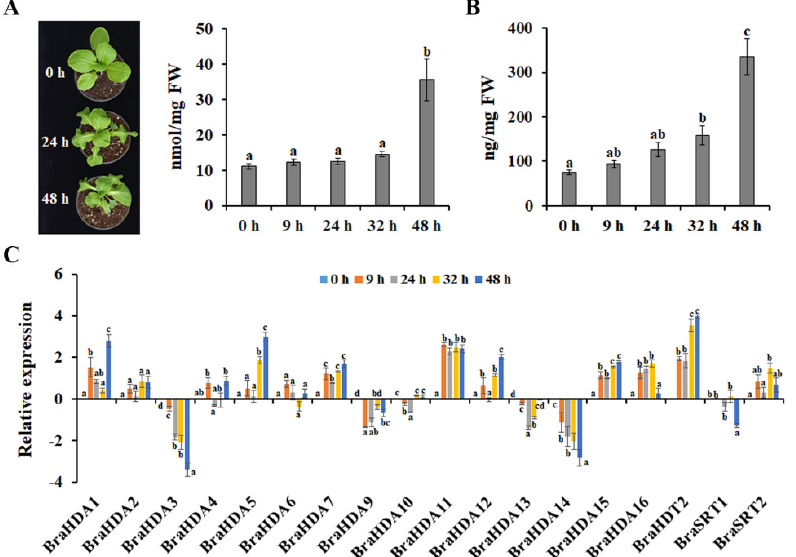
Figure 2. Physiological response to heat stress in Chinese cabbage. Changes in malondialdehyde ( A ) and proline ( B ) levels after exposure to heat stress (40 °C) were determined. ( C ) Expression patterns of Brassica rapa histone deacetylases ( BraHDACs) in response to heat stress. Expression is indicated as a log2 ratio of experimental treatments relative to the values at 0 h. The bars represent the mean ± standard error across three independent experiments. Different letters indicate statistically significant differences ( p < 0.05).